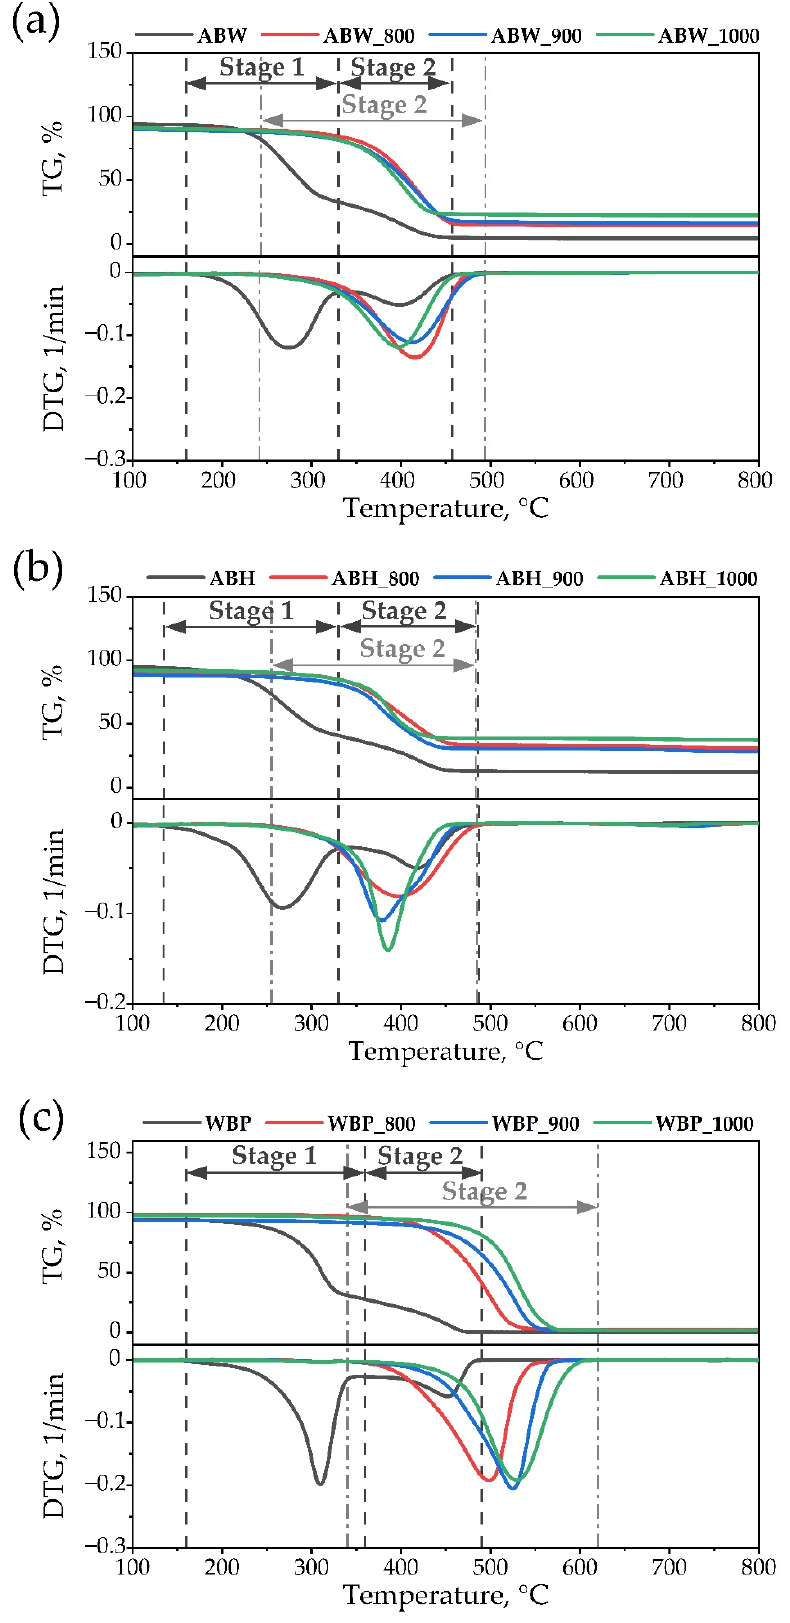
Figure 4. TG and DTG curves of ( a ) ABW, ( b ) ABH and ( c ) WBP.